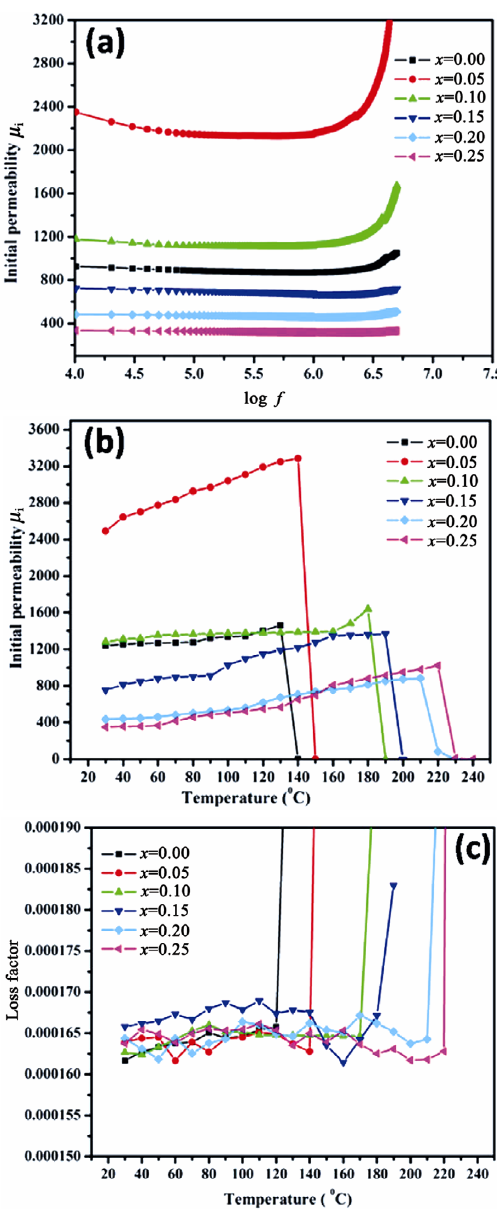
Fig. 8 Permeability studies of the ferrites: (a) frequency dependency of initial permeability dependency of permeability and loss